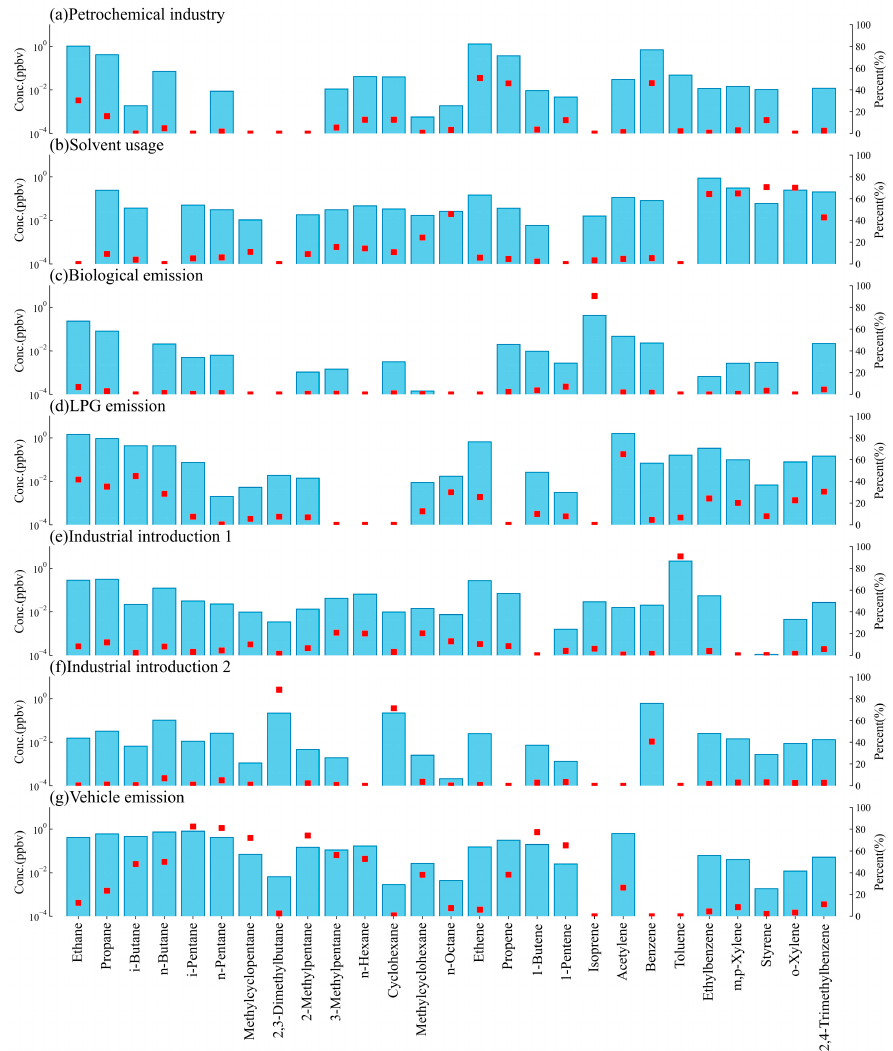
Figure 7. The source profiles (blue bars) and distributions of each species for the different factors (red squares) in the summer. ( a ) Petrochemical industry; ( b ) Solvent usage; ( c ) Biological emission; ( d ) LPG emission; ( e ) Industrial introduction 1; ( f ) Industrial introduction 2; ( g ) Vehicle emission.